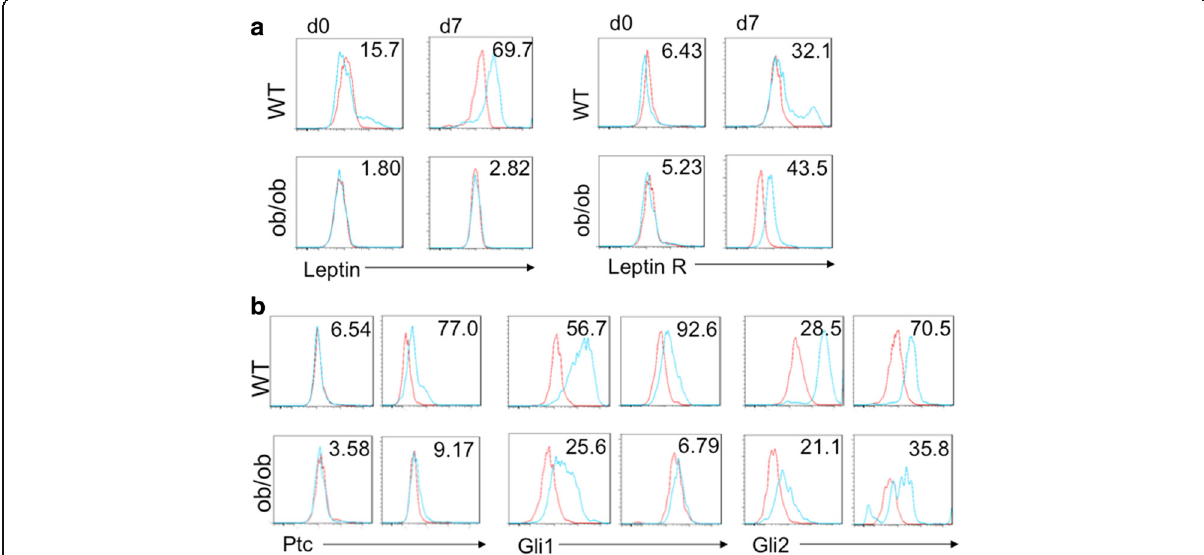
Fig. 1 Genetic Leptin Deficiency Does Not Alter Leptin Receptor Expression But Suppresses Hh Activity in HSCs. a . Primary HSCs were isolated from WT mice or ob/ob mice, and cultured on plastic dishes in serum-containing medium for 2 h (d0) or 7 days (d7). FACS analysis of ( left ) Leptin and ( right ) Leptin receptor (OBRa plus OBRb) immunoreactivity in quiescent (day 0, d0) and myofibroblastic (culture day 7, d7) HSCs. Red lines indicate Isotype controls. b . FACS analysis analysis of Hh target gene products (Ptc, Gli1, Gli2) in quiescent and myofibroblastic HSC from WT and ob/ob mice. Red lines indicate Isotype